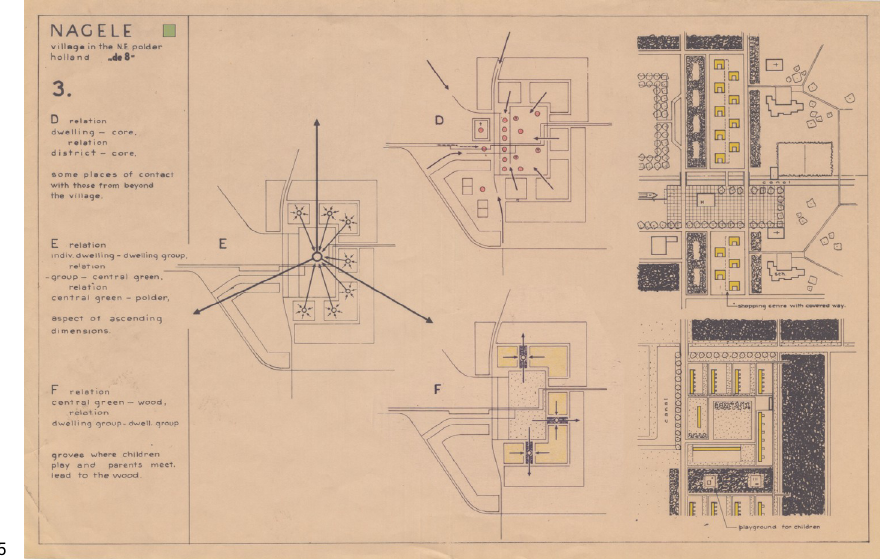
Fig. 5 Third panel of four of van Ey- ck’s ‘Nagele Grid’ as presented at Ciam 10. From: Max Risselada and